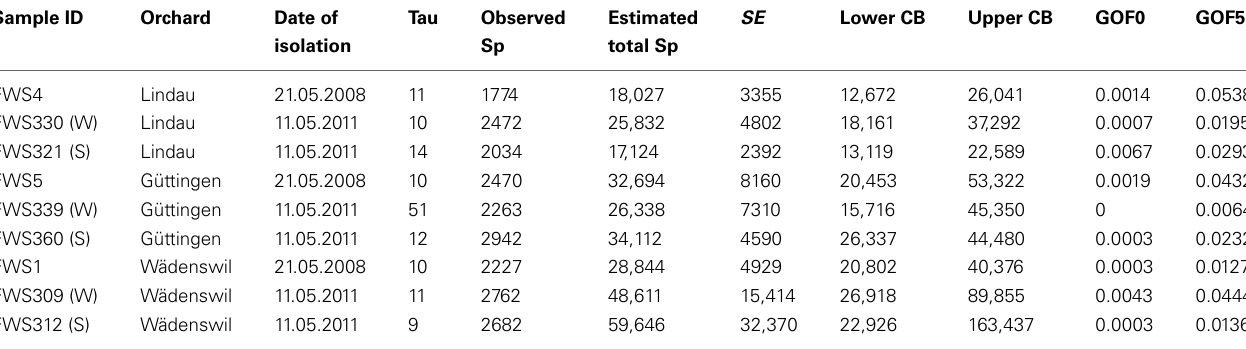
Table 2 | CatchAll statistical analysis of bacterial 16S sequence diversity